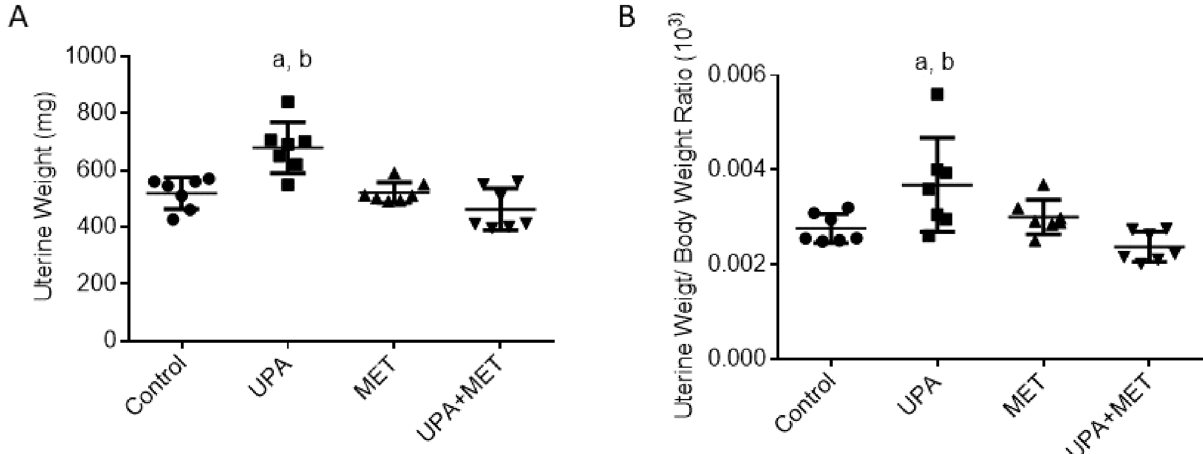
Figure 1. Effect of ulipristal or/ and metformin treatment on the rats’ uteri weight ( A ), uterus weight/body weight ( B ). Data is represented by mean ± SD (n = 7). a or b, Statistically significant from control or ulipristal and metformin treated group respectively at P < 0.05 using one-way ANOVA followed by Tukey as a post hoc test. UPA ulipristal, MET metformin, UPA + MET co-treatment with ulipristal and